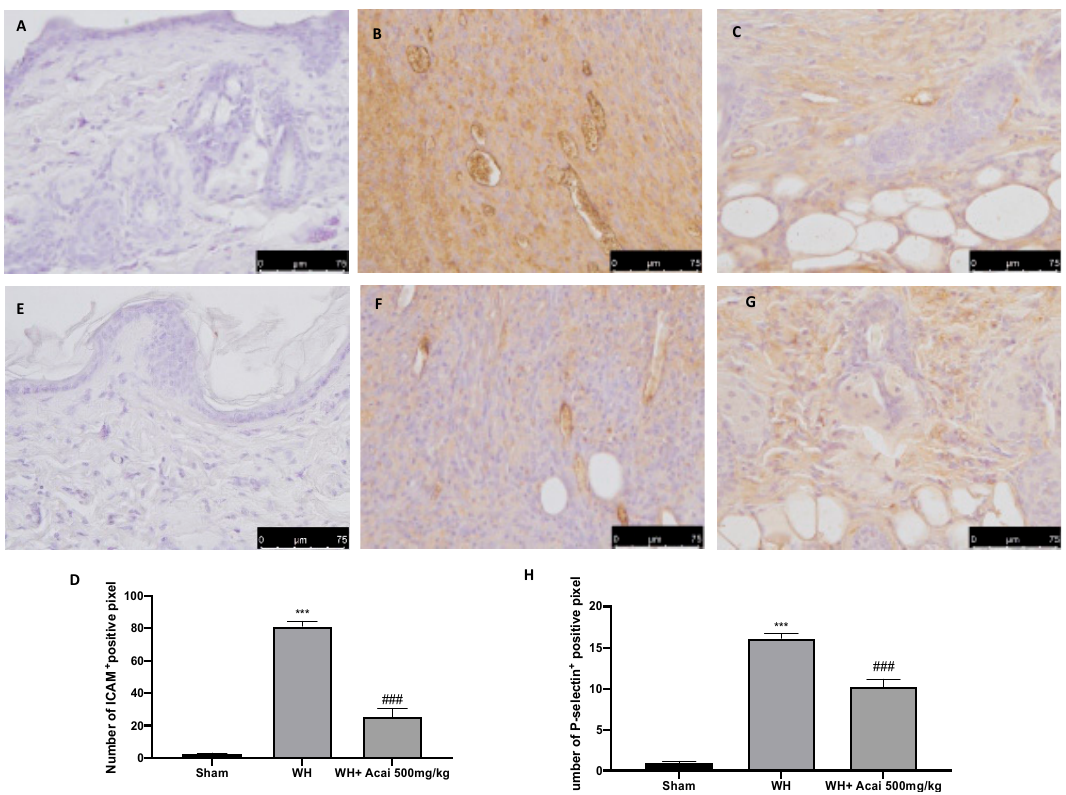
Figure 4. Immunohistochemical analysis of adhesion molecules. ICAM expression: sham ( A ), WH ( B ), WH + açai berry ( C ), % positive pixel for ICAM ( D ). P-selectin expression: sham ( E ), WH ( F ), WH + açai berry ( G ), % positive pixel for P-selectin ( H ). A 75 × magnification is shown. A demonstrative blot of lysates with a densitometric analysis for all animals is shown. Data are expressed as the mean ± SEM of N = 6 mice/group. *** p < 0.001 vs. sham; ### p < 0.001 vs. WH